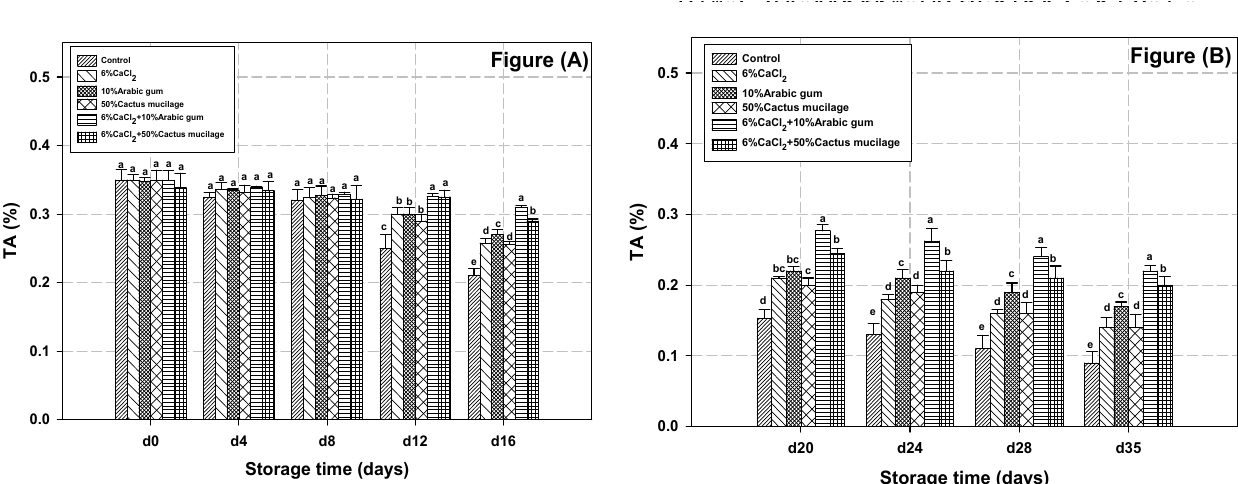
Fig. 6 (A, B): Effect of natural substance combination with CaCl 2 on the titratable acid of tomatoes fruit at cold storage (10 °C). Means followed by the same letter are not significantly different (Duncan’s multiple range test, P >